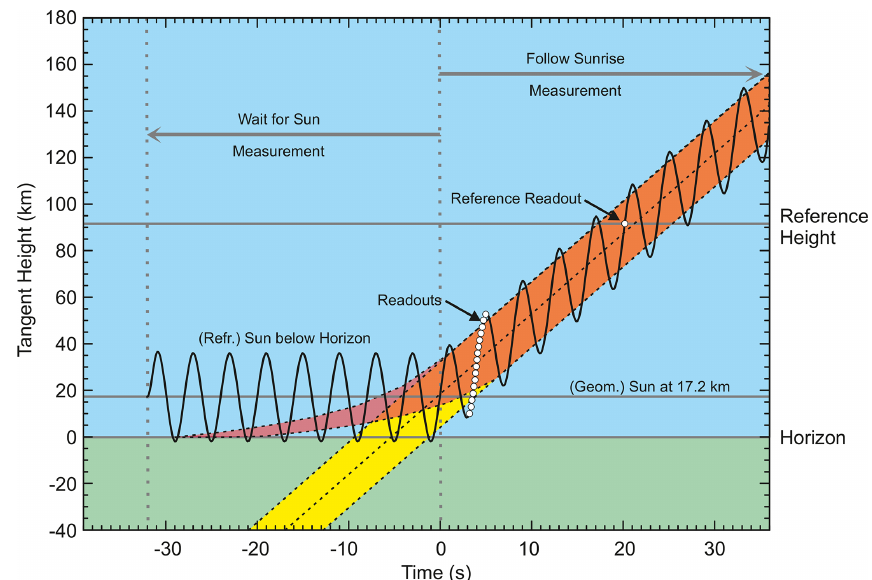
Figure 1. SCIAMACHY solar occultation measurement (figure from Noël et al.,